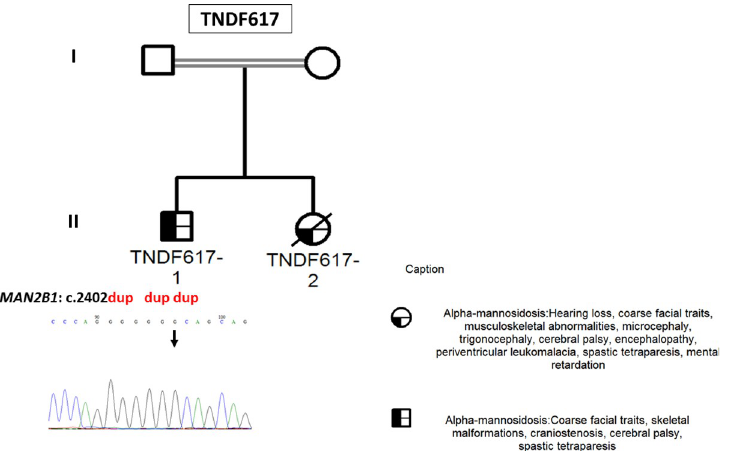
Fig 1. TNDF617 Family pedigree and chromatogram of the disease-causing variant identified in the MAN2B1 gene. The arrows indicate the cases for whom the molecular diagnosis was performed. Double lines indicate consanguinity. Red and bold denote the MAN2B1 gene (NM_000528.4) variant c.2402dup carried by the index case (TNDF617-1).